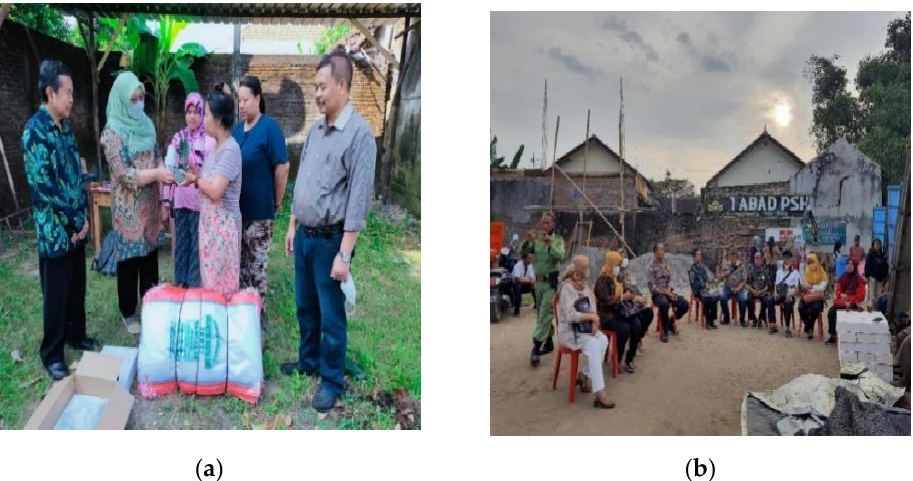
Figure 3. ( a ) Intervention for making organic fertilizer houses; ( b ) gazebo-making intervention for selling agricultural products.